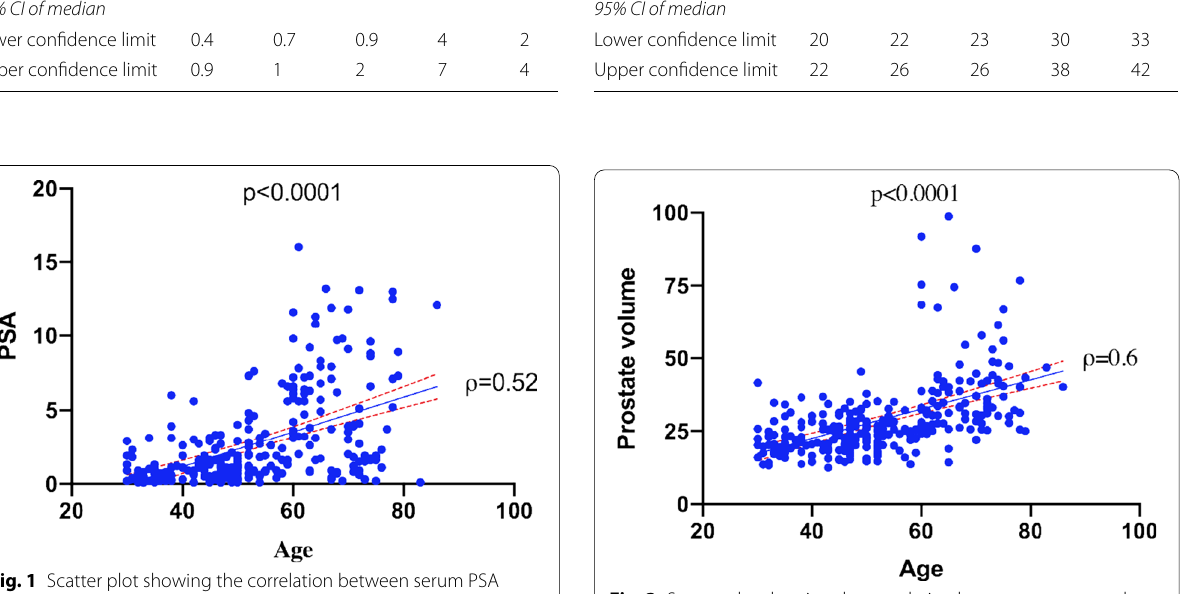
Fig. 3 Scatter plot showing the correlation between prostate volume and participants’